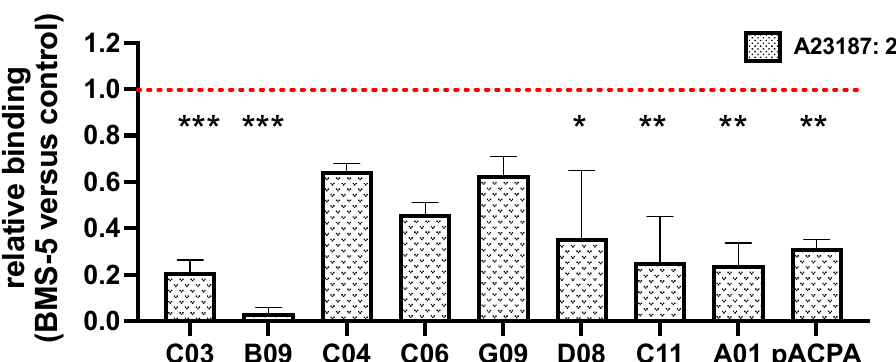
Figure 4. The PAD4 inhibitor BMS-5 reduces ACPA binding to neutrophil-derived antigens Human peripheral blood neutrophils were pre-treated with the BMS-5 or DMSO for 30 min at room temperature, followed by their activation with A23187. The cells were thereafter fixed, permeabilized and stained with different monoclonal or polyclonal ACPA preparations. Average values are shown, calculated from at least three independent experiments. *** p < 0.001, ** p < 0.01, * p < 0.05.